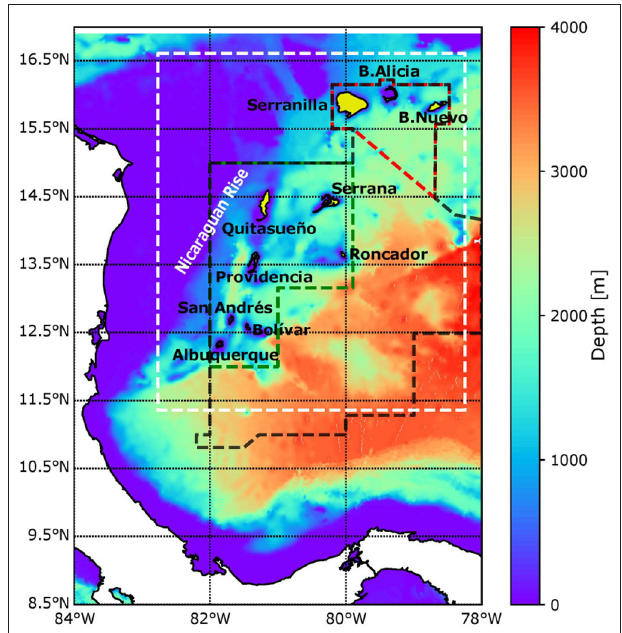
FIGURE 1 | Parent domain for numerical integrations. White dashed lines indicate the nested domain, black dashed lines enclose the Seaflower Reserve, and green and red lines show the MPA and common regime area between Colombia and Jamaica, respectively. Background bathymetry and the black polygons indicating release and recruitment zones in the Lagrangian Model are from the Millennium Coral Reef Mapping Project.